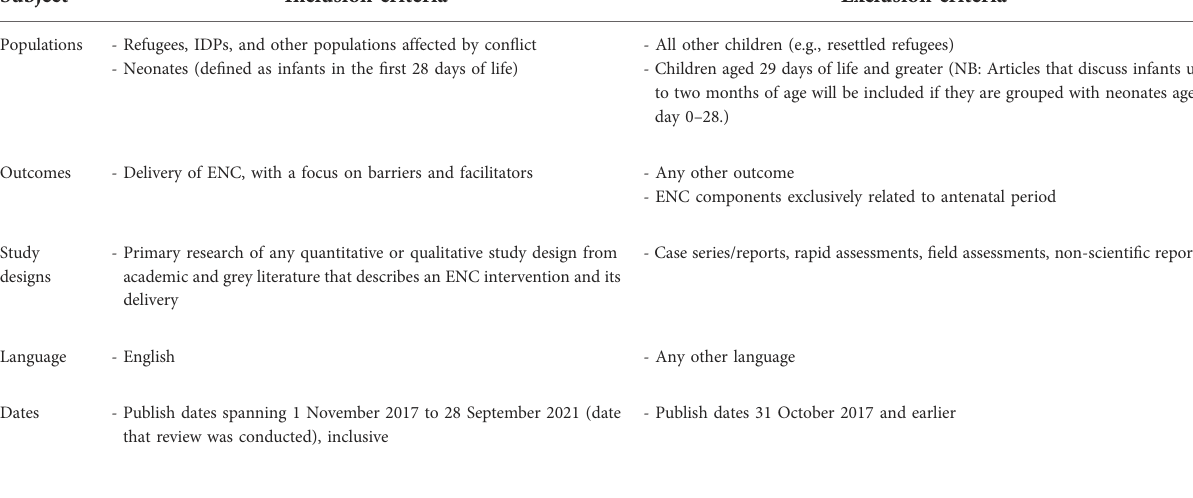
TABLE 1 Inclusion and exclusion criteria for systematic